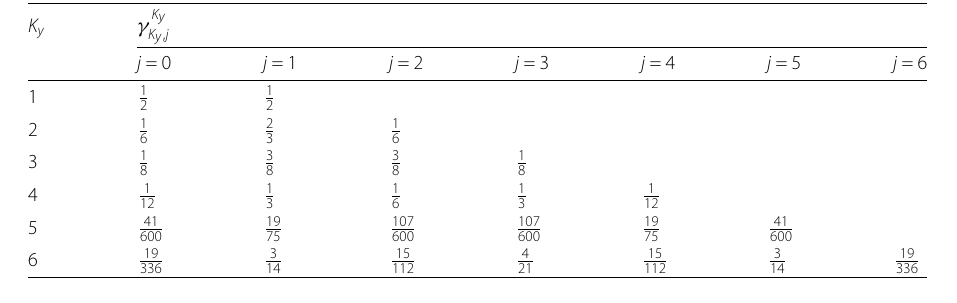
K y } K y until K y = 6 j =0 K y , j